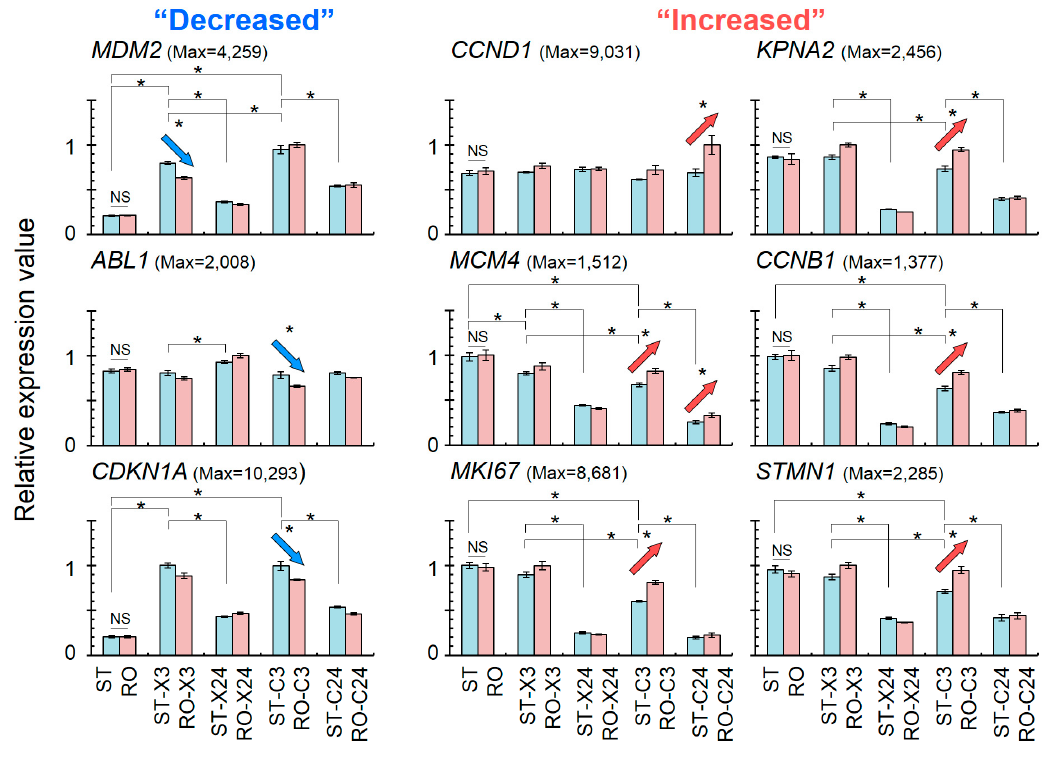
Figure 3. Comparison of relative expression value changes of nine cell cycle-related genes screened via Step 3 and Step 4 in Figure 2; relative expression values were determined by dividing the normalized expression value of each condition by the maximum value (Max) in each gene. The normalized expression values were calculated by CLC Main Workbench software. ST, standing 1 G ; RO, rotation for simulated µ G ; X, X-ray irradiation; C, carbon-ion irradiation; 3, 3 h after irradiation; 24, 24 h after irradiation. Significantly decreased relative expression values as revealed by statistical analysis with EDGE (* p < 0.05, NS = not significant) are shown with blue arrows and increased ones with red arrows. Bar graphs indicate relative expression value ± standard error under each condition (ST or RO alone, N = 6; the other 8 conditions, N = 3).